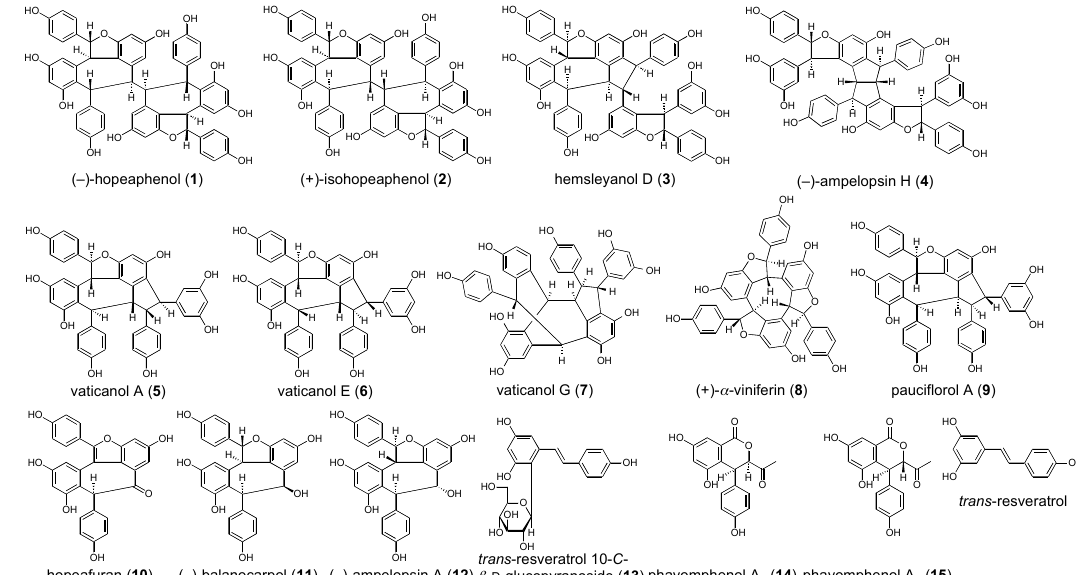
Figure 1. Stilbenoids and dihydroisocoumarins ( 1 – 15 ) from the bark of Shorea roxburghii .